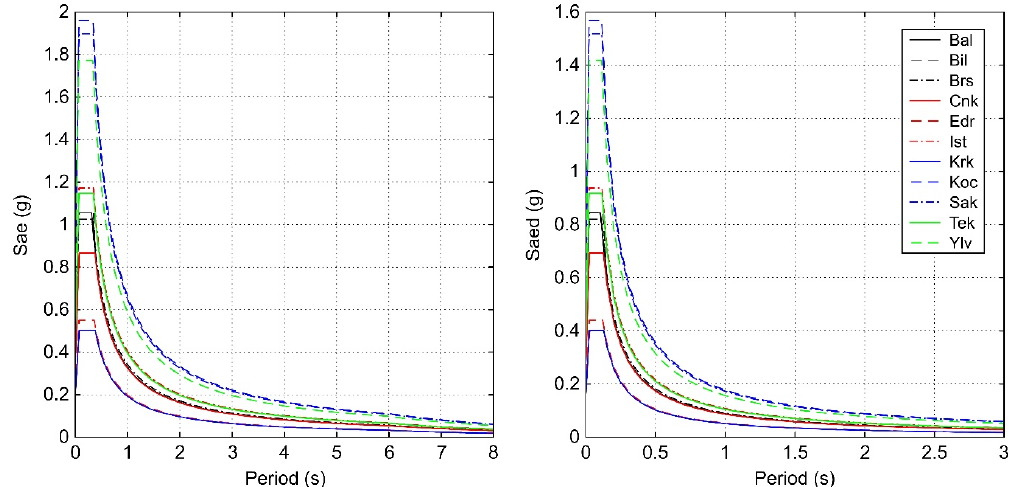
Figure 4. Horizontal elastic design spectrums ( left panel ) and vertical elastic design spectrums ( right panel ).